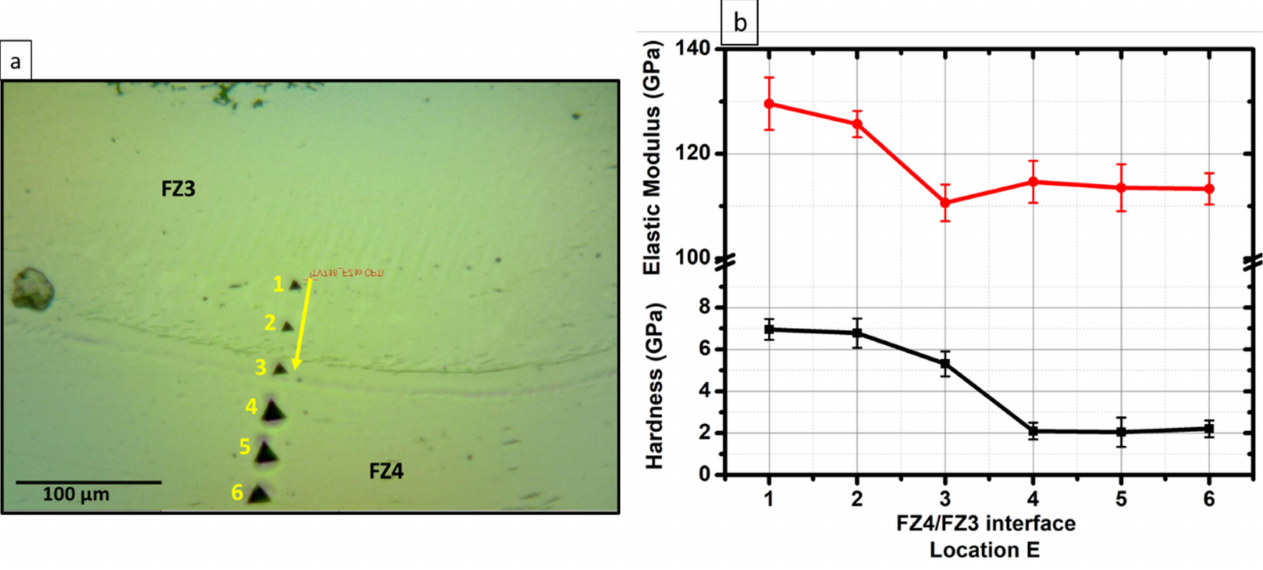
Figure 13. ( a ) Nanohardness line scan at FZ3/FZ4 Interface (location (E) in Figure 8). ( b ) CorreScheme 718. interface has a relatively higher nanohardness, approximately 30% greater than FZ2 (which has the highest hardness after the V/IN718 interface) and 70% greater than the IN718 base